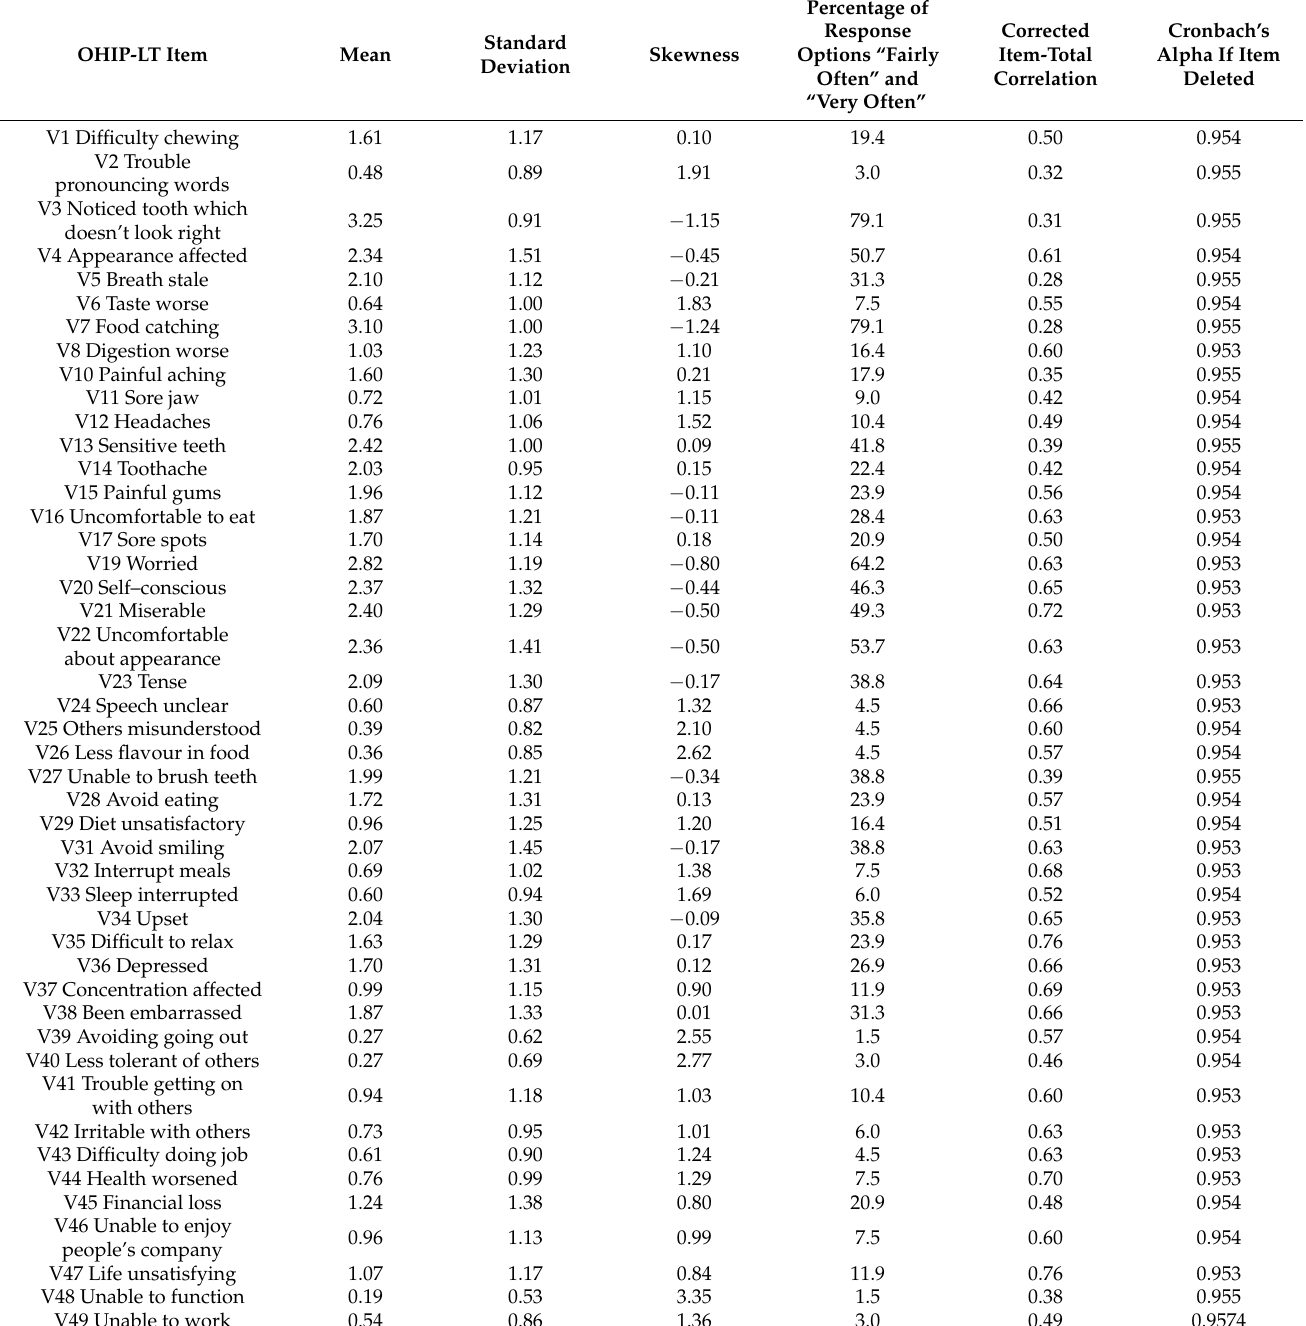
Table 1. Psychometric characteristics of the OHIP-LT items ( n =